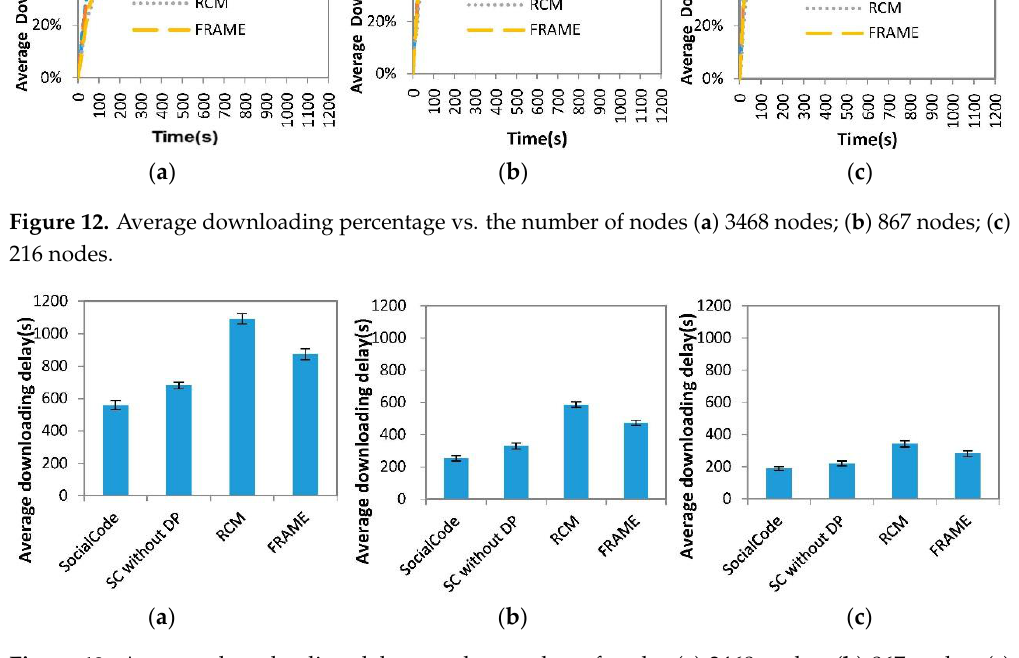
Figure 13. Average downloading delay vs. the number of nodes ( a ) 3468 nodes; ( b ) 867 nodes; ( c ) 216 nodes.